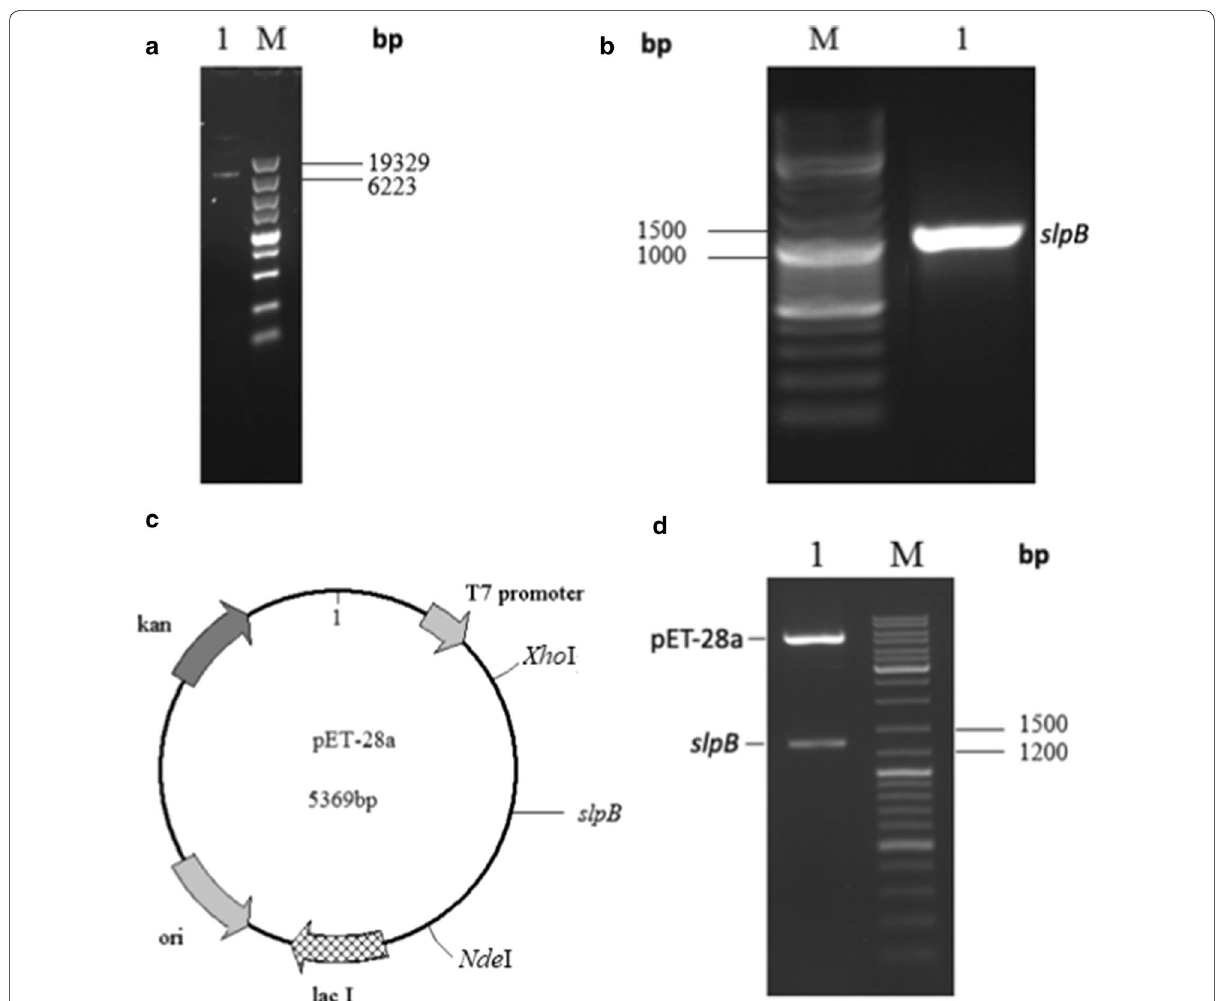
Fig. 1 Construction of a recombinant pET-28a-slpB expression vector. a Total DNA of Lactobacillus acidophilus NCFM. b PCR amplification result of slpB gene. c Construction of pET-28a-slpB. d Identification of pET-28a-slpB by restriction